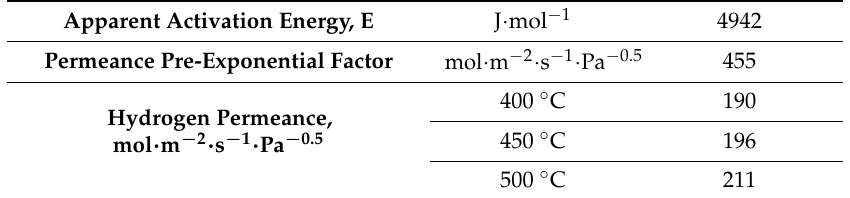
Figure 11. Arrhenius plot of hydrogen permeance. Table 4. Apparent activation energy, pre-exponential factor and hydrogen permeance values.